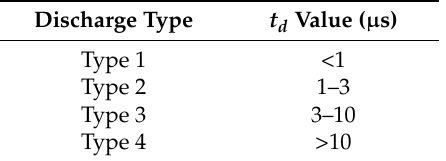
Table 2. Discharge discrimination as a function of ignition delay time t d .